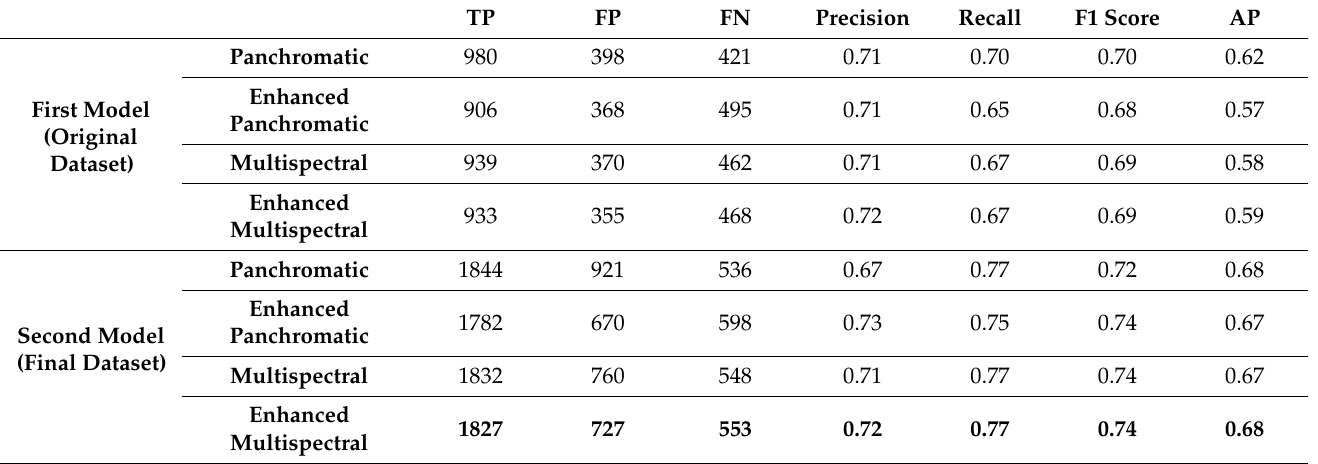
Table 4. Delineation accuracy of mapping smallholder field boundaries in Bihar from models trained using WV-3 data in Bihar. The accuracy metrics from the model with the best F1 score and AP values are highlighted in bold.